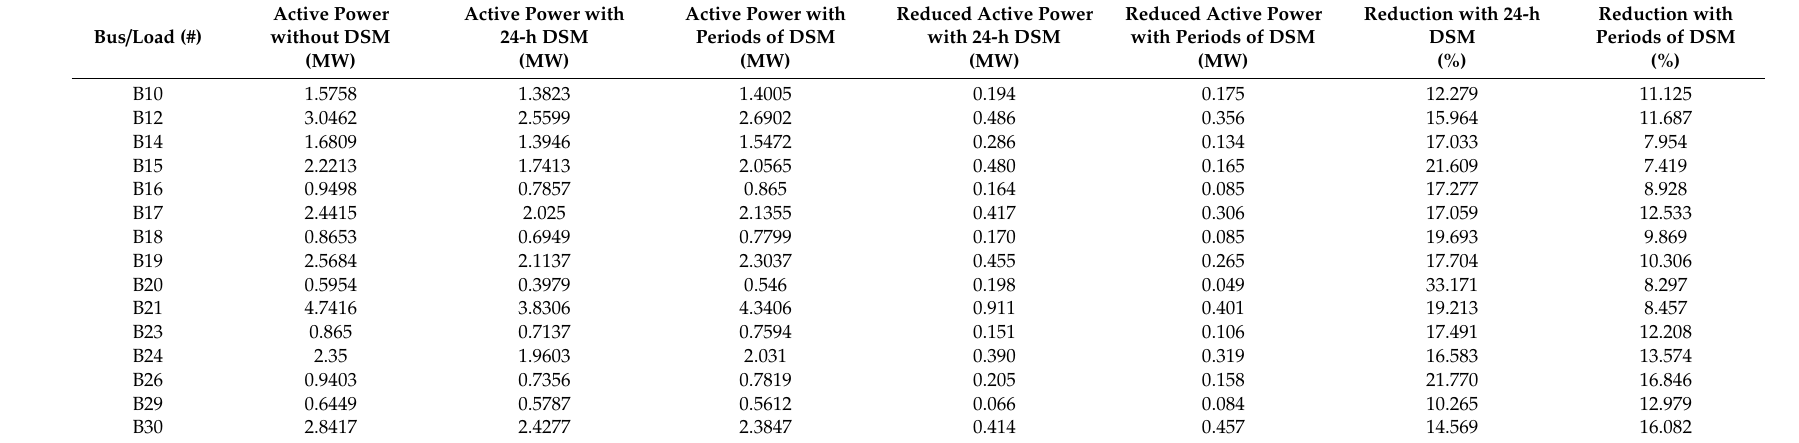
Table 10. Case VIII: Active power with / without DSM in the presence of DG.